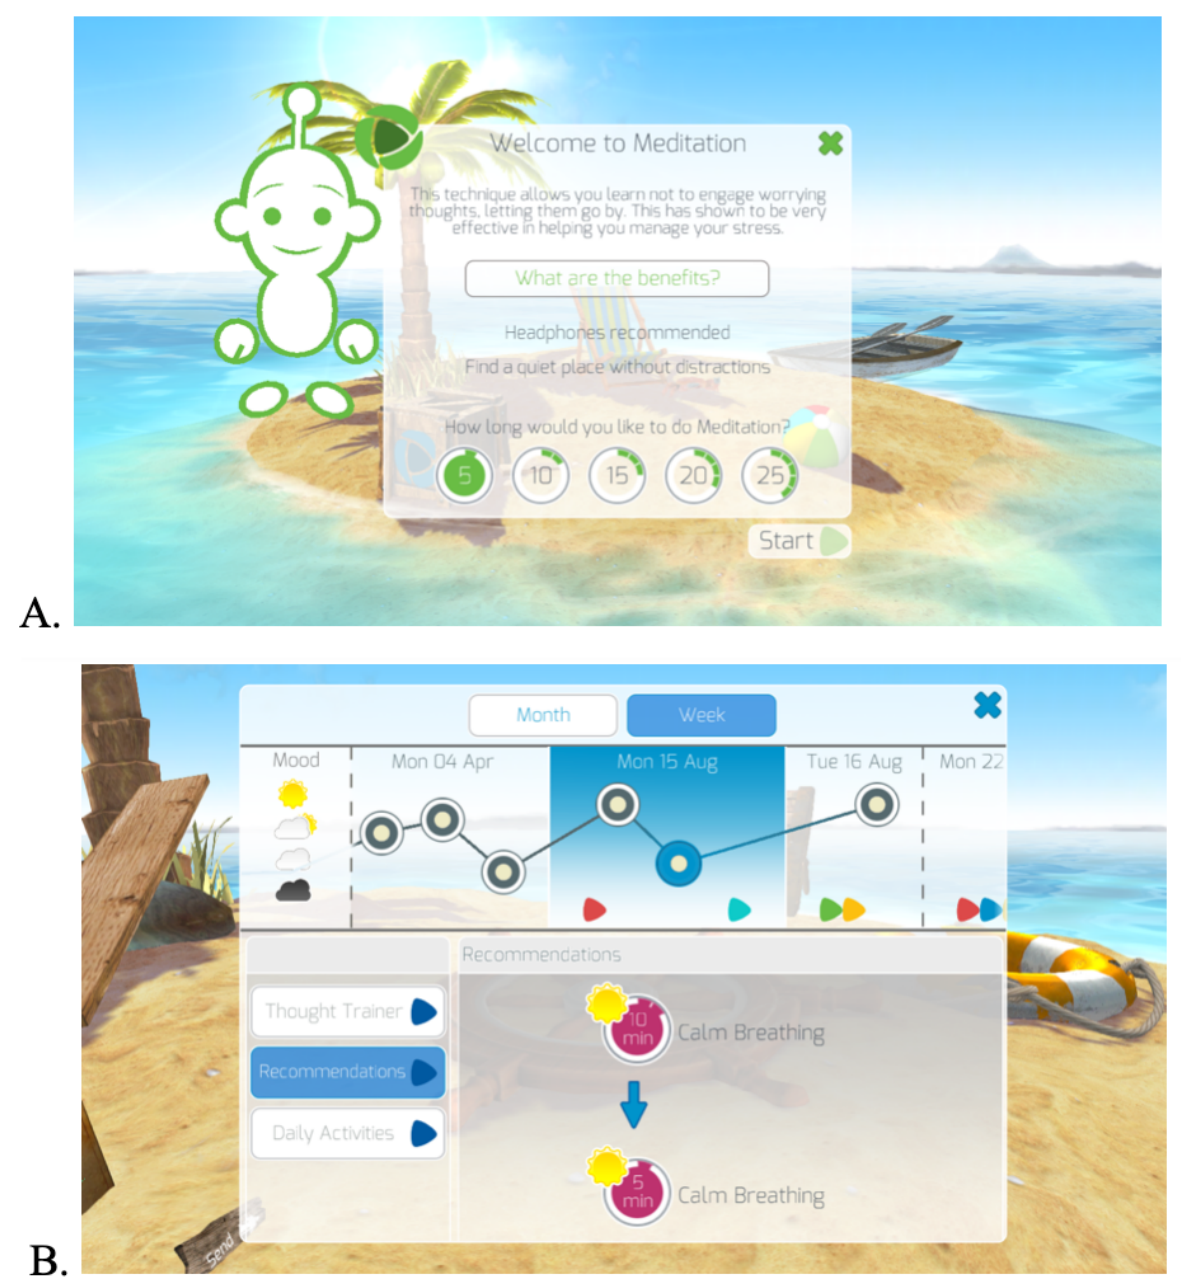
Figure 1. Screenshots of the Feel Stress Free app on a smartphone, showing the landing page for the meditation activity (A) and the mood tracker with an activity recommendation